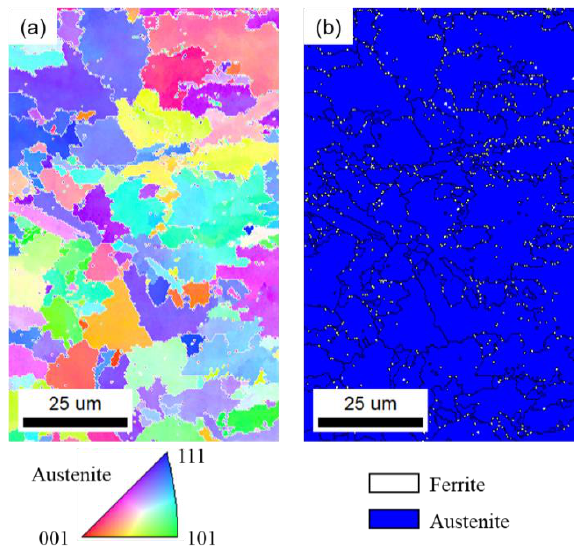
Figure 11. Electron back scatter diffraction (EBSD) measurement results of the microstructure of the cross-section of the weld joint of SUS304 stainless steel during laser welding at the welding speed of 1.0 m/min. ( a ) Orientation color map with the color legend ; ( b ) phase mapping with the grain boundary.